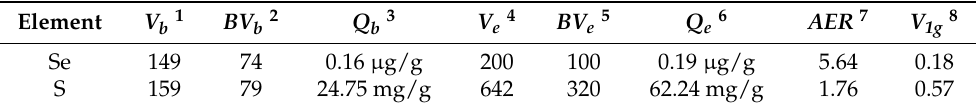
Table 2. Test results for LDH removal of Se and S from cooling tower (CT) blowdown water in testbed column.